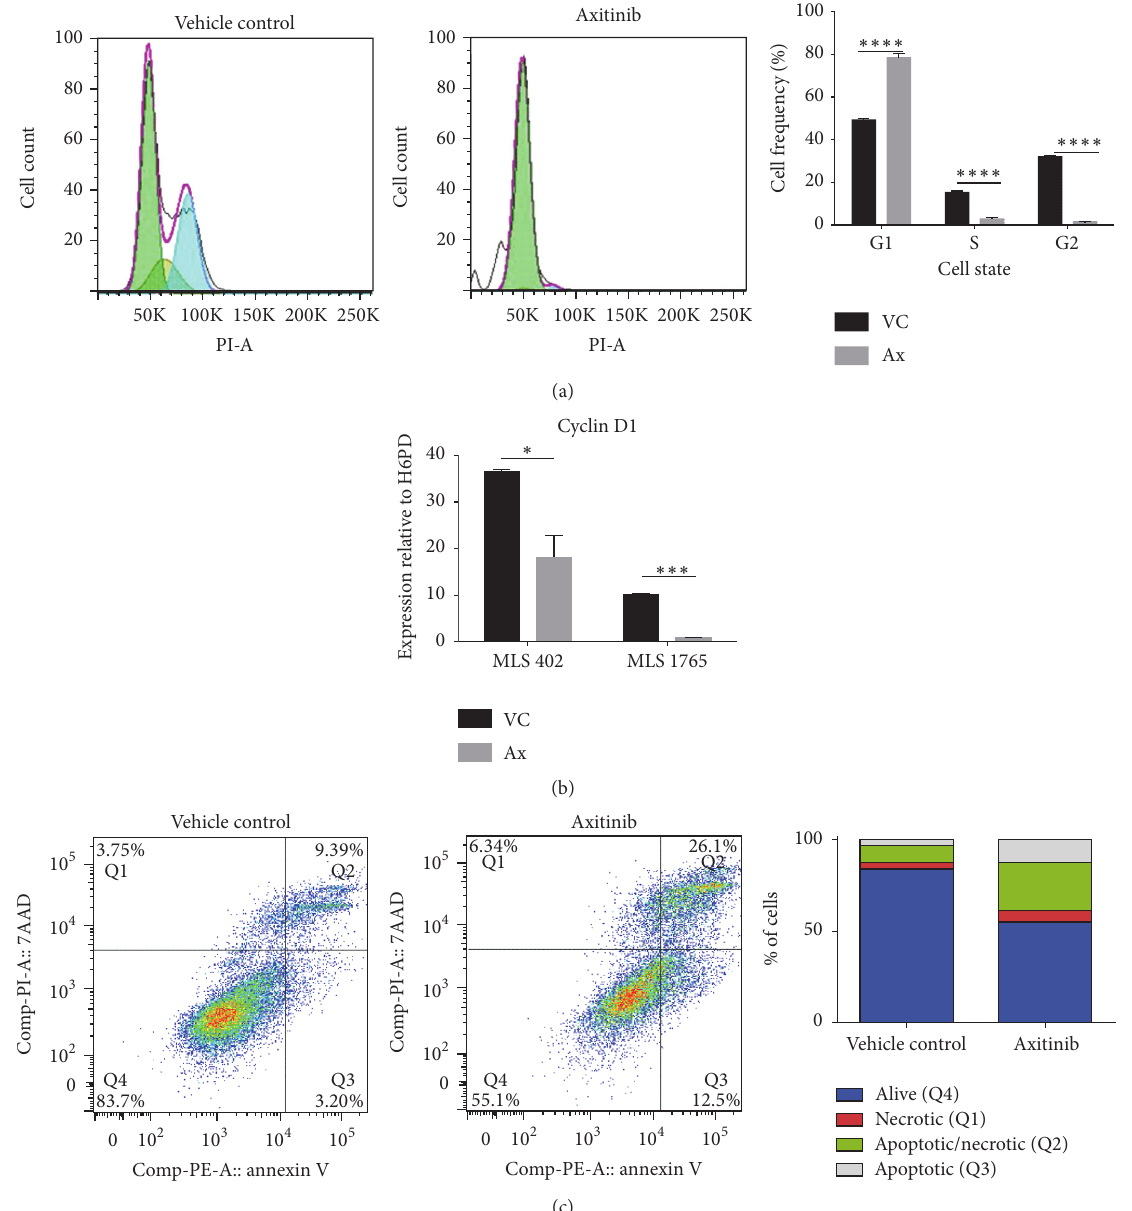
Figure 5: Axitinib affects cell cycle and apoptosis. MLS 1765 cells were treated with IC 50 axitinib (3.2 𝜇 M) or vehicle control overnight and then examined using a cell cycle assay. Green represents G1; yellow, S; and blue, G2. Three biological replicates were tested. The data are presented as the mean + SEM (a). MLS 402 and MLS 1765 cells were treated with IC 50 axitinib (MLS 402, 1.2 𝜇 M; MLS 1765, 3.2 𝜇 M) or vehicle control overnight and then analyzed by RT-qPCR for the expression of cyclin D1 (b). MLS 1765 cells were treated overnight with IC 50 axitinib or vehicle control and then assessed using an annexin V apoptosis assay. Biological triplicates were performed. Data represent an individual test that was representative of repeats (c). Ax, axitinib; VC, vehicle control; LO, Lipofectamine-only treated cells; Ut, untreated MLS cells. A paired, two-tailed 𝑡 -test was performed. ∗ 𝑝 < 0.05 ; ∗∗∗ 𝑝 < 0.001 ; ∗∗∗∗ 𝑝 < 0.0001 .